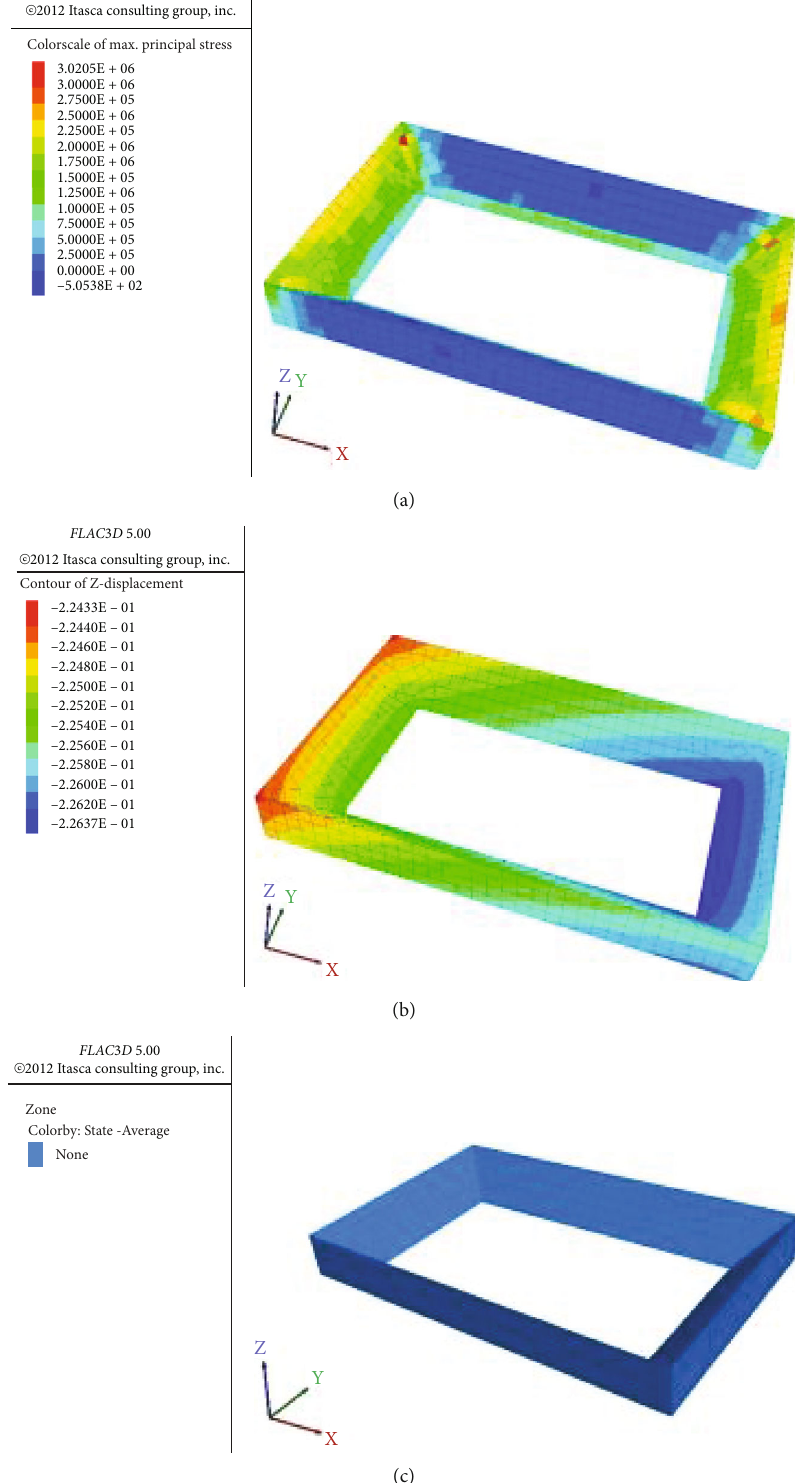
Figure 11: Cloud map of stress, displacement, and plastic zone distribution of the reinforcement boat pond when coalface advanced 1000 m: (a) cloud map of the maximum principal stress; (b) cloud map of displacement; (c) cloud map of plastic